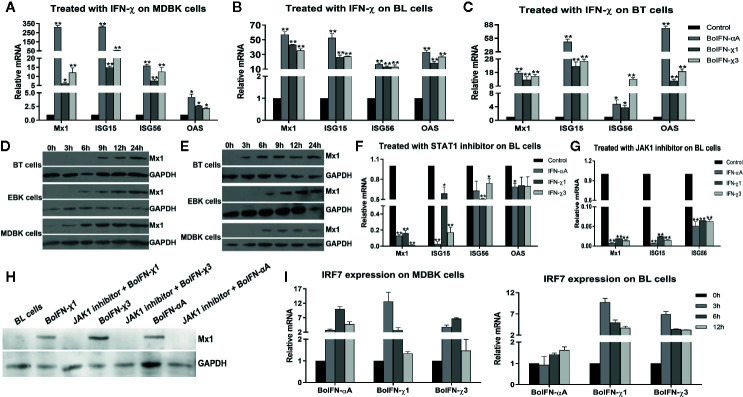
ISG expression induced with BoIFN-χs. (A–C) Transcription of ISGs in MDBK/BL/BT cells with BoIFN-χs treatment. BoIFN-χ1 (5 μg/mL) and BoIFN-χ3 (5 μg/mL) were separately incubated in cells for 6 h, and then, the cells were collected for qPCR. BoIFN-αA (5 μg/mL) was used as positive control, and the cells without IFN incubation were used as a mock-treated control. (D, E) Western blotting of expression of Mx1 protein upon BoIFN-χs treatment. BoIFN-χ1 (5 μg/mL) and BoIFN-χ3 (5 μg/mL) were separately incubated in cells for 0–24 h, and then the cells were collected for western blotting. (F, G) Transcription of ISGs in BL cells upon BoIFN-χs treatment followed by treatment with a STAT1/JAK1 inhibitor. BL cells were pretreated with STAT1/JAK1 inhibitor for 2 h, and then, the BoIFN-χ1 (5 μg/mL) and BoIFN-χ3 (5 μg/mL) were separately added in cells for another 6 h, the cells were collected for qPCR. BoIFN-αA (5 μg/mL) was used as positive control, and the cells without inhibitors were used as mock-treated control. (H) Western blotting of expression of Mx1 protein upon BoIFN-χs treatment followed by treatment with a JAK1 inhibitor. BL cells were pretreated with JAK1 inhibitor for 2 h, and then, the BoIFN-χ1 (5 μg/mL) and BoIFN-χ3 (5 μg/mL) were separately added in cells for another 12 h, and the cells were collected for western blotting. BoIFN-αA (5 μg/mL) was used as positive control. (I) Transcription of IRF7 in MDBK/BL cells upon BoIFN-χs treatment for 3–12 h. GAPDH was used as the internal reference control, and cells without IFN treatment were used as the mock-treated control. Data are the mean ± SD (n = 3) of one representative experiment. *P < 0.05, **P < 0.01.